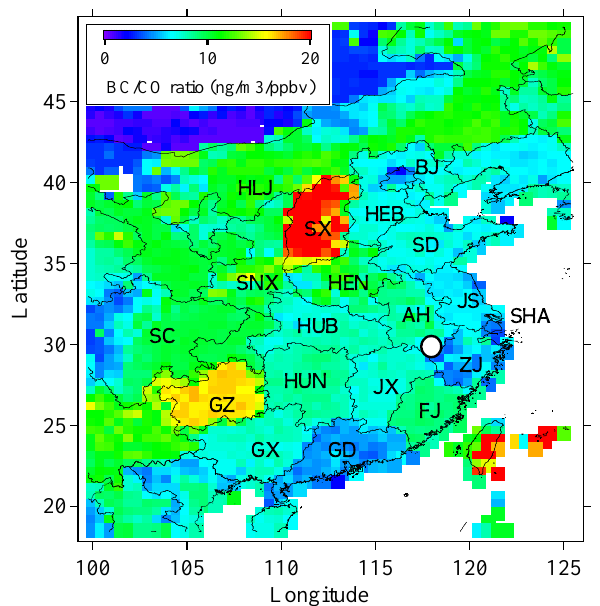
Fig. 1. Spatial distribution of 1 BC/ 1 CO ratio with grid resolu- tion of (0.5 ◦ × 0 . 5 ◦ ) from INTEX-B anthropogenic emission inven- tory. The black circles indicate the location of the observation site. Correspondingly 1 BC/ 1 CO ratios are converted from GgGg − 1 to ngm − 3 ppbv − 1 by assuming that in Standard Temperature and Pressure condition. Abbreviations in the plot are BJ (Beijing), HEB (Hebei), SX (Shanxi), SD (Shandong), HEN (Henan), JS (Jiangsu), SNX (Shaanxi), HUB (Hubei), SC (Sichuan), SH (Shanghai), AH (Anhui), HUN (Hunan), JX (Jiangxi), ZJ (Zhejiang), FJ (Fujian), GD (Guangdong), GX (Guangxi), and GZ